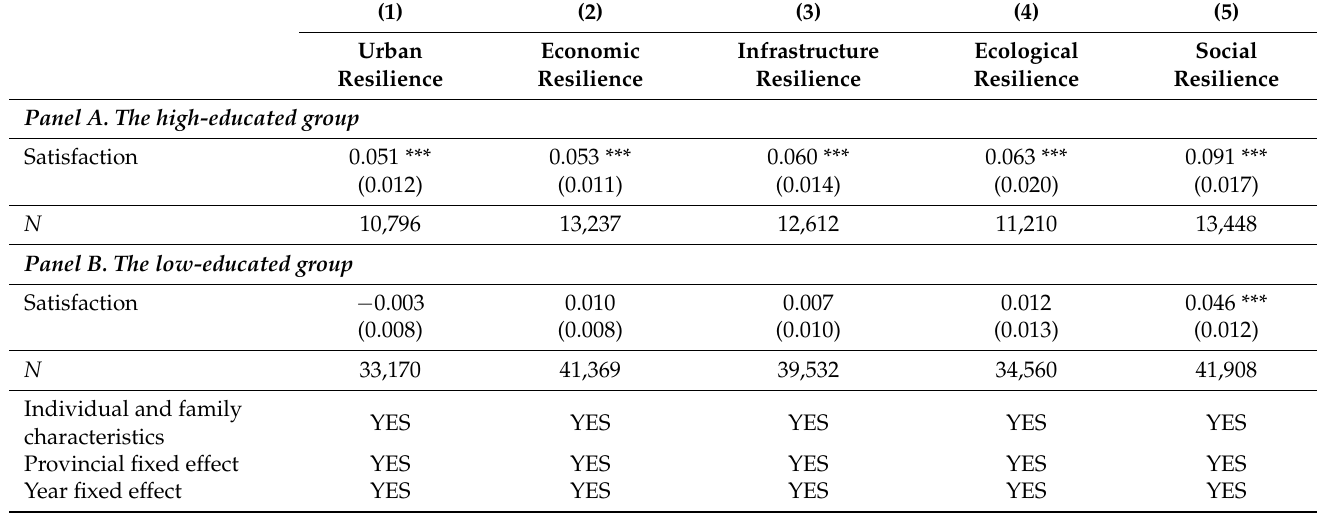
Table 4. Effect of urban resilience on residents’ subjective happiness by years of schooling.